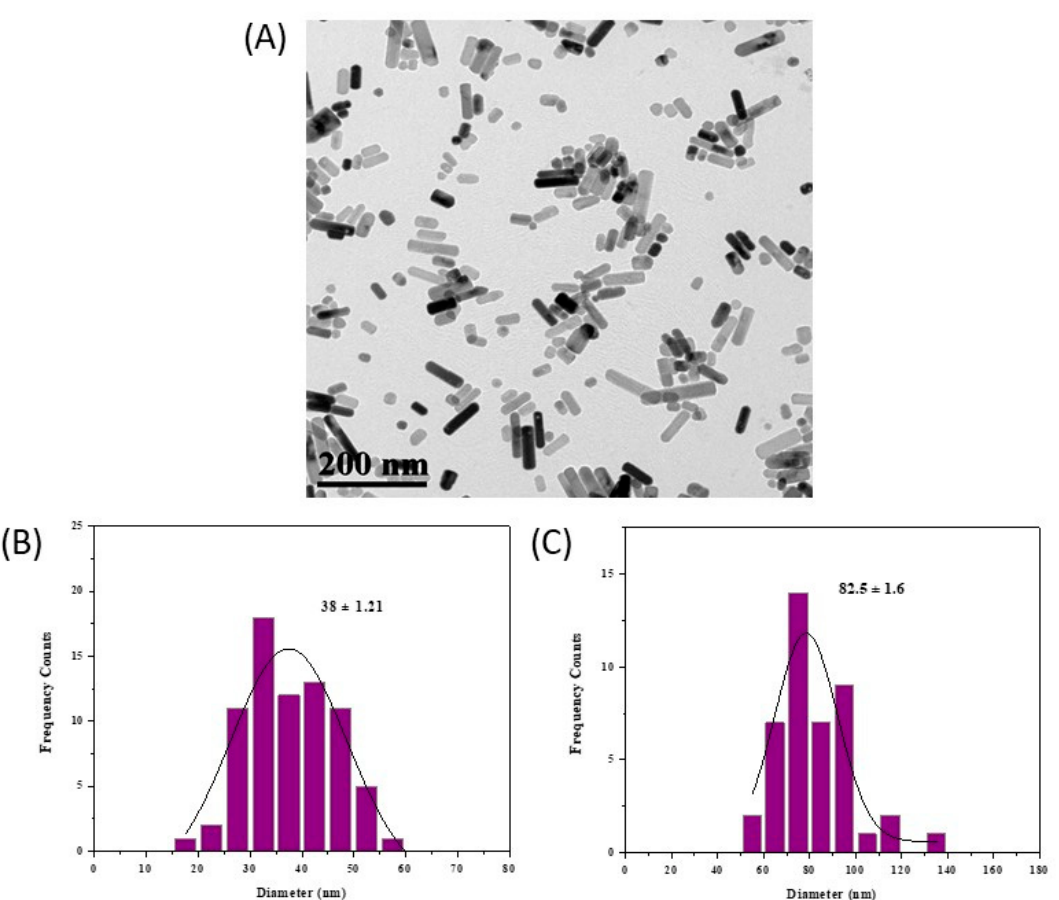
Figure 2. TEM image of ZnO@OAm NRs (NRs; rod-shaped nanoparticles) ( A ), average length histogram and Gaussian fit (38 ± 1.21 nm); and ( B ) average length histogram and Gaussian fit (82.5 ± 1.6 nm) ( C ) of the NRs. The average size of particles is expressed as mean size ± SD. The Fourier-transform infrared (FT–IR) spectrum of ZnO@OAm NRs (4000–400 cm − 1 )